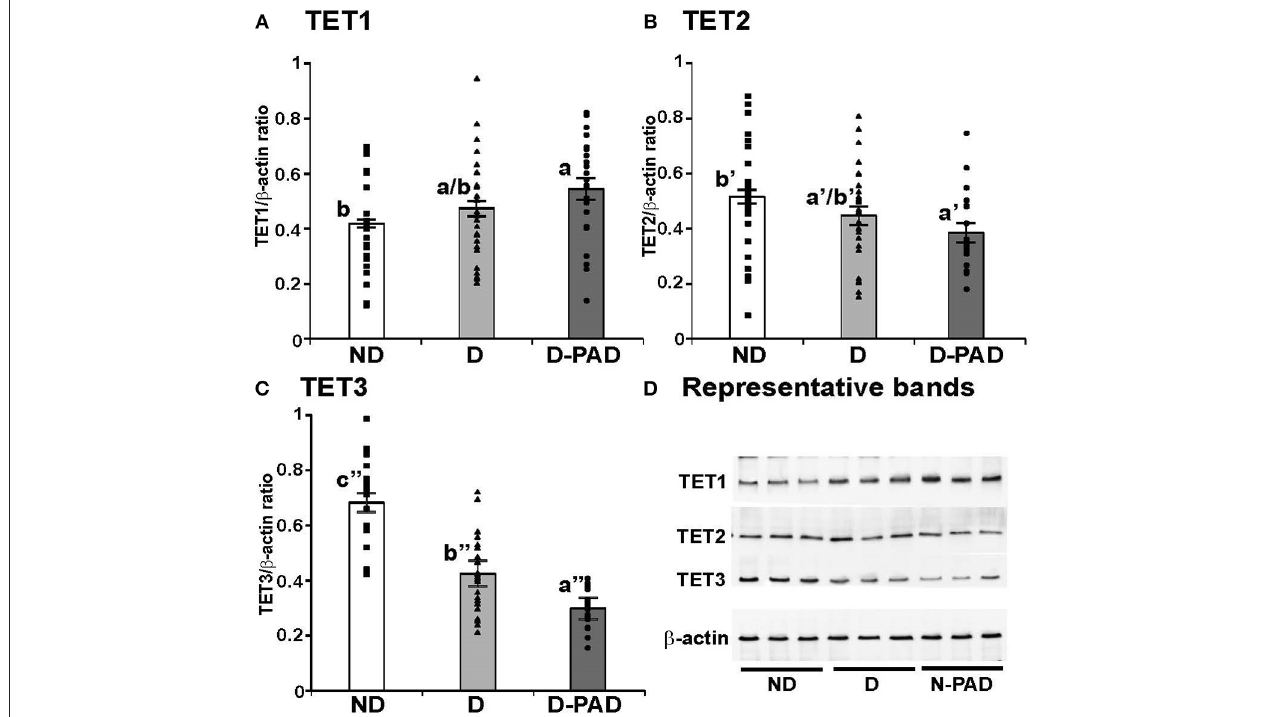
FIGURE 3 | Comparison of the relative expression levels of TET1 (A) , TET2 (B), and TET3 (C) protein, and representative immunoblot results of these three proteins (D) in EPCs of subjects in ND, D and D-PAD groups. EPCs were isolated from subjects in ND ( n = 22), D ( n = 28), and D-PAD ( n = 22) groups and cultured as described in the Material and Methods section. Total cellular proteins of EPCs were isolated and subjected to immunoblot using the specific antibodies to β -actin (the invariable loading control), TET1, TET2, and TET3. The distribution ranges of the ratios of the densities of the indicated protein to β -actin were shown with the columns in the graph. The results were presented as mean ± SEM of the ratios of the indicated protein to β -actin. (D) shows the representative immunoblot images of TET1, TET2, TET3, and the house-keeping protein β -actin using three protein samples each in ND, D, and D-PAD groups. The data were analyzed with one way ANOVA (a > b, P < 0.03 for comparing ND and D-PAD groups; a ′ < b ′ , P < 0.02 for comparing ND and D-PAD groups; a ′′ < b ′′ < c ′′ , P < 1.12E-07 for comparing ND and